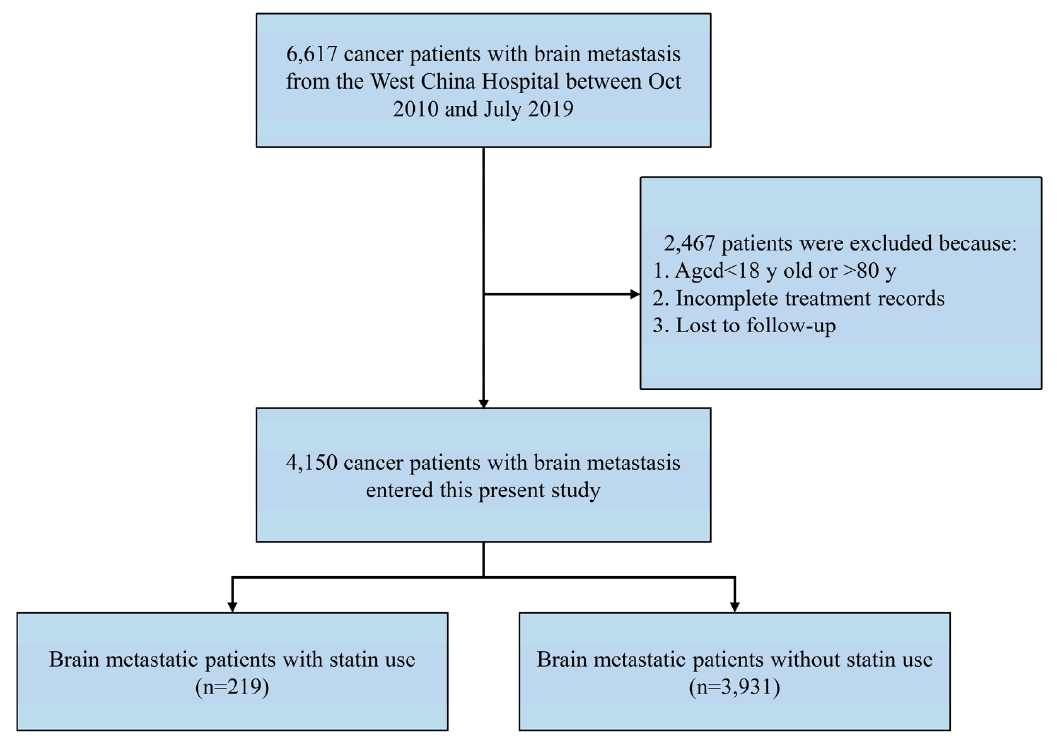
Figure 2. The flow diagram in the patient selection process.